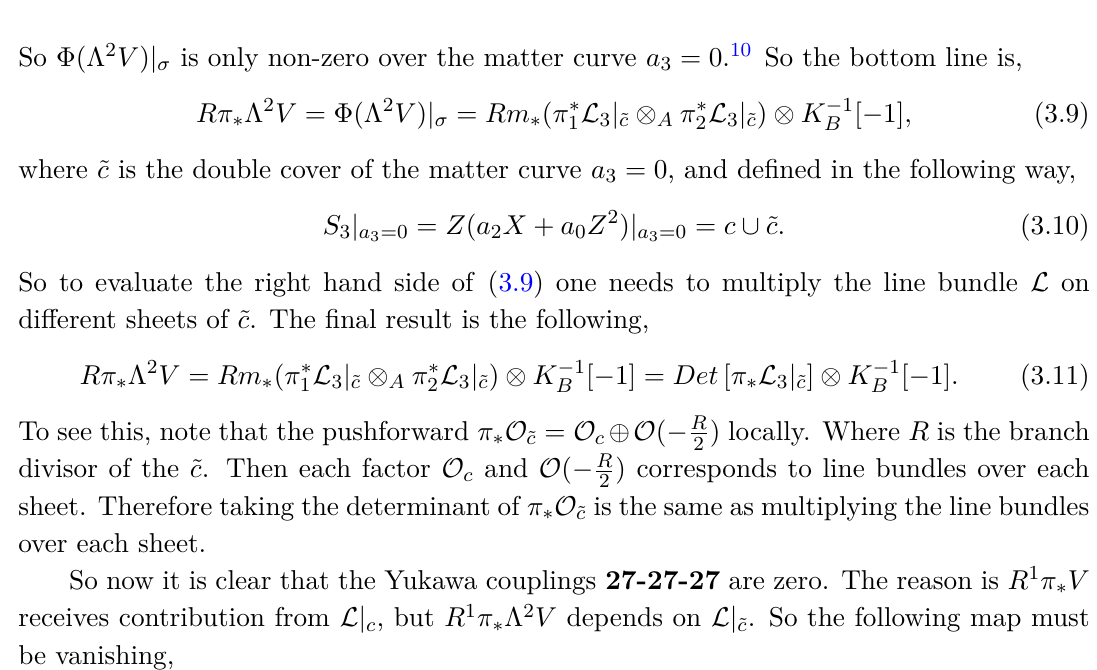
Figure 3 . Left: the preimage of the matter curve inside the spectral cover. This is a reducible cover of c , where one component is isomorphic to the matter curve (the orange line) and one m component is a double cover of the matter curve (green line). Right: the matter curve, i.e., the intersection locus of the zero section and the spectral